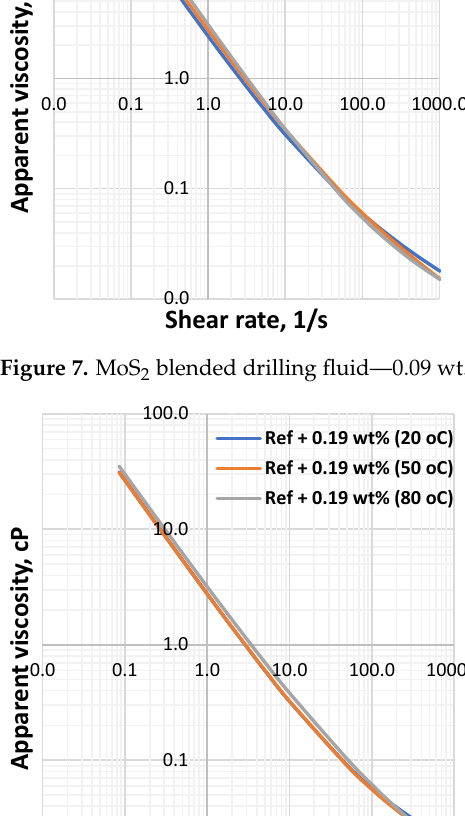
Figure 8. MoS 2 mixed drilling fluid—0.19 wt.%.